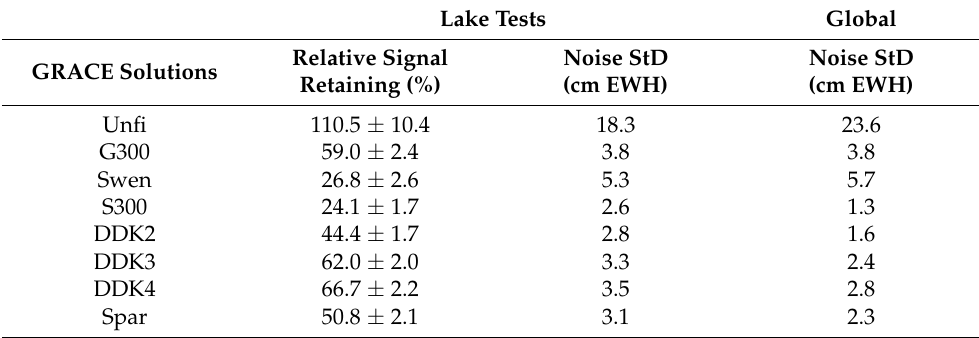
Figure 9. Noise StD for the eight filtered solution time-series under consideration estimated at the nodes of a global 1° × 1° grid with the VCE method.